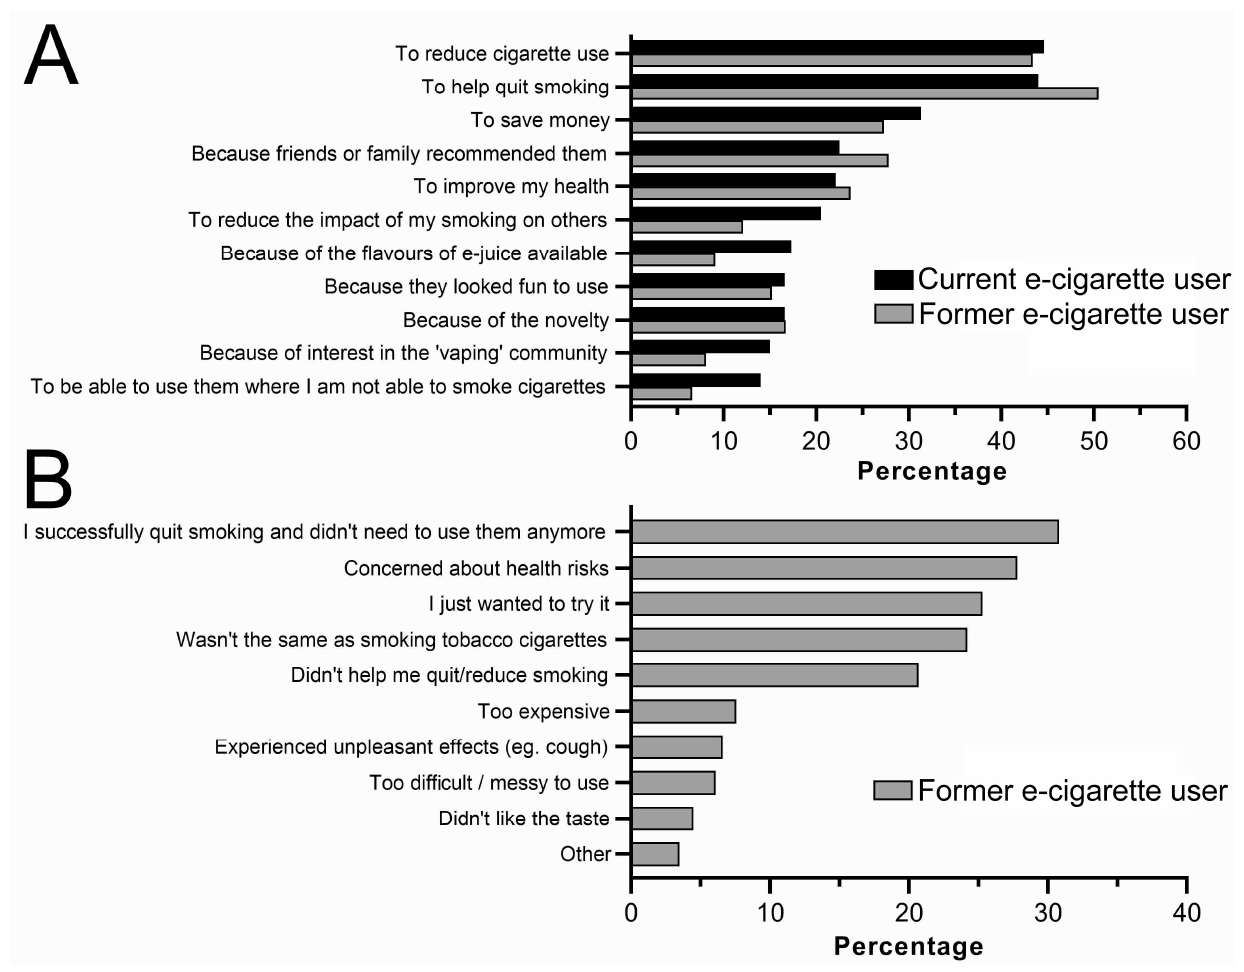
Figure 2. Reasons Australian adult current and former e-cigare tt e users commenced ( A ) or stopped ( B ) e-cigare tt e use. Data are % of respondents—with respondents permi tt ed to select more than one ( B ) e-cigarette use. Data are % of respondents—with respondents permitted to select more than one reason. n = 307 (current e-cigare tt e users) and n = 198 (former e-cigare tt e users). reason. n = 307 (current e-cigarette users) and n = 198 (former e-cigarette